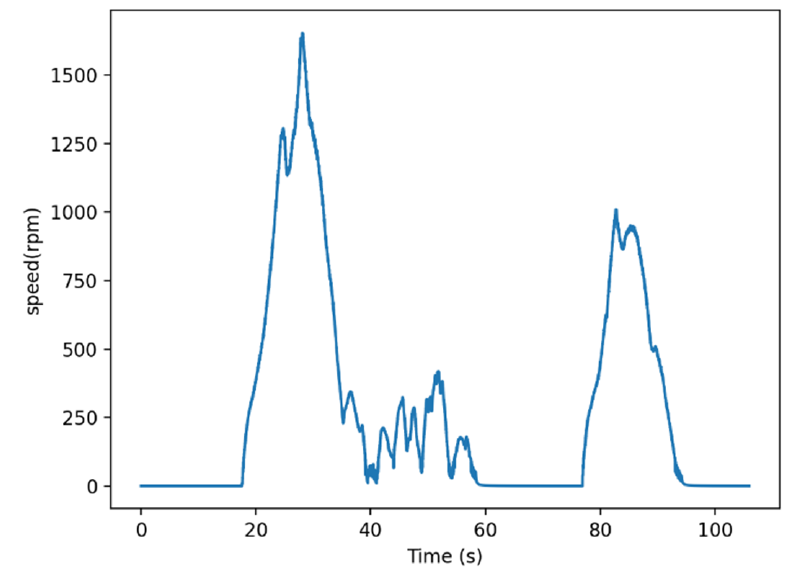
Figure 9. Speed sequence diagram of typical working cycle. Table 5. Eigenvalue comparison of typical working cycle and the average values.